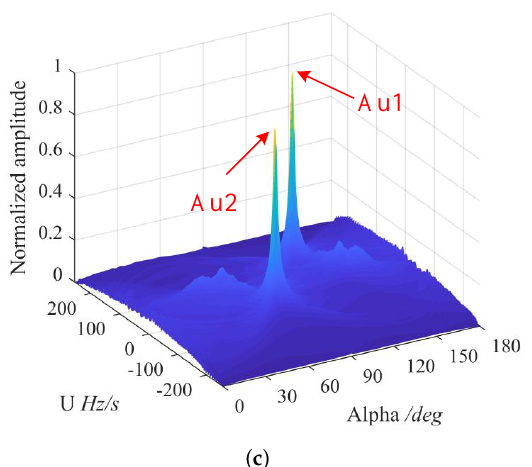
Figure 2. Simulation results. ( a ) Contour of the relative time t –relative frequency f τ 2 space of CPF. ( b ) Contour of α –u space of BEFRFT. ( c ) Stereogram of ( b